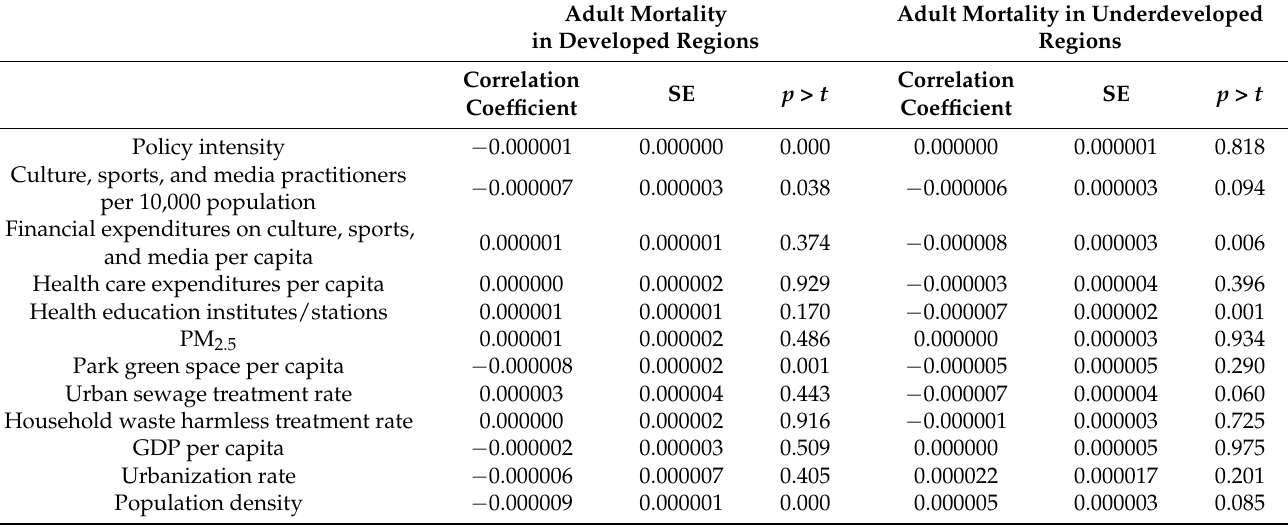
Table 4. Regression results of